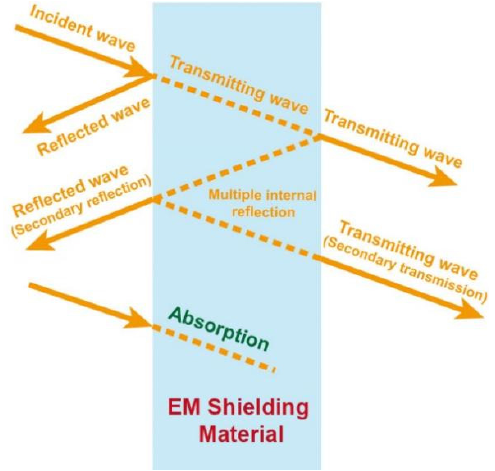
Figure 2. Schematic representation of the shielding mechanism.